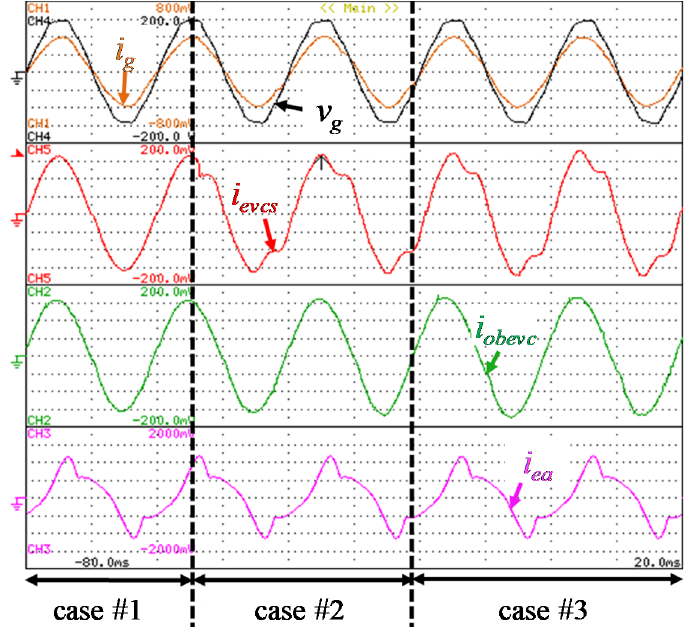
Figure 28. Experimental results during the MF-EVCS operation combined with the operation of an on-board EV charger (compensating current harmonics and power factor): Ac-side voltage ( v g : 50 V/div); Total home current ( i g : 20 A/div); Ac-side current of the MF-EVCS ( i evcs : 5 A/div); Ac-side current of the on-board EV charger ( i obevc : 5 A/div); Current consumed by the electrical appliances ( i ea : 5 A/div).